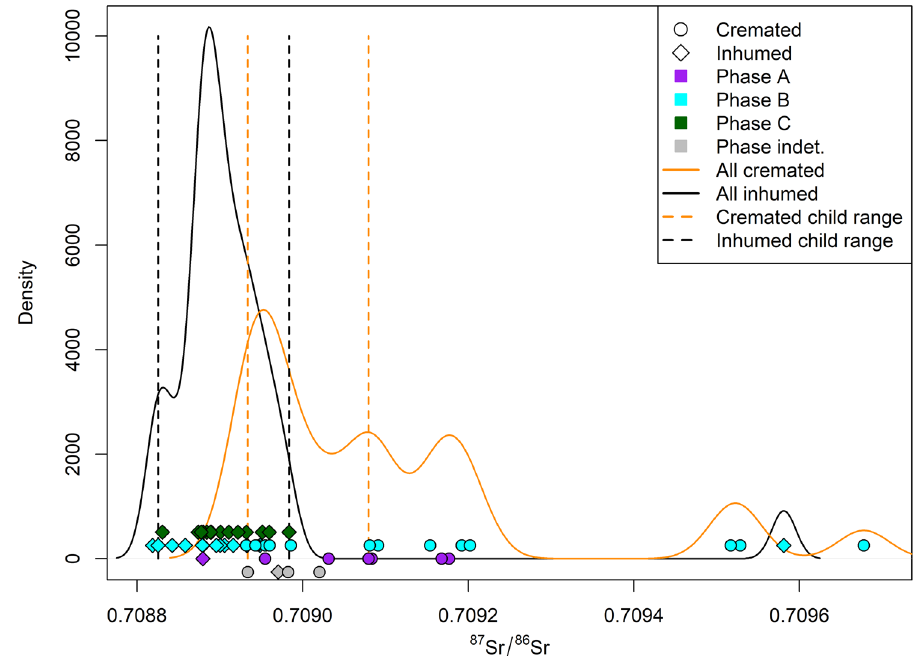
Figure 6. Density plot of cremated and inhumed 87 Sr/ 86 Sr values for Fermo according to chronological phases. Dots: cremated individuals; diamonds: inhumed individuals; purple: Phase A (end of the ninth century to the beginning of the eighth century BCE); light blue: Phase B (second half of the eighth century BCE); green: Phase C (seventh and sixth century BCE); grey: indeterminate chronology; orange dotted lines: cremated children range (0.70893–0.70908); black dotted lines: inhumed children range (0.70883–0.70898).